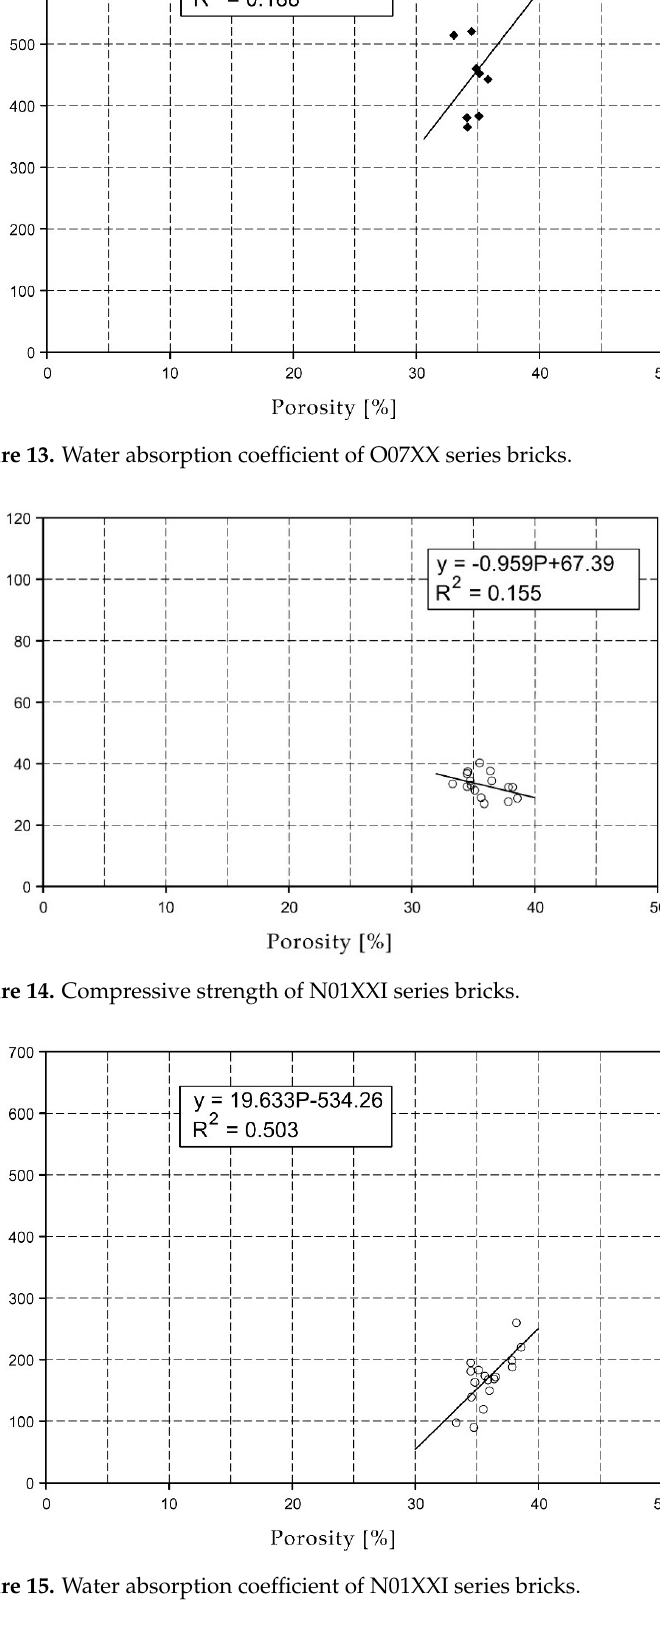
Figure 15. Water absorption coefficient of N01XXI series bricks.